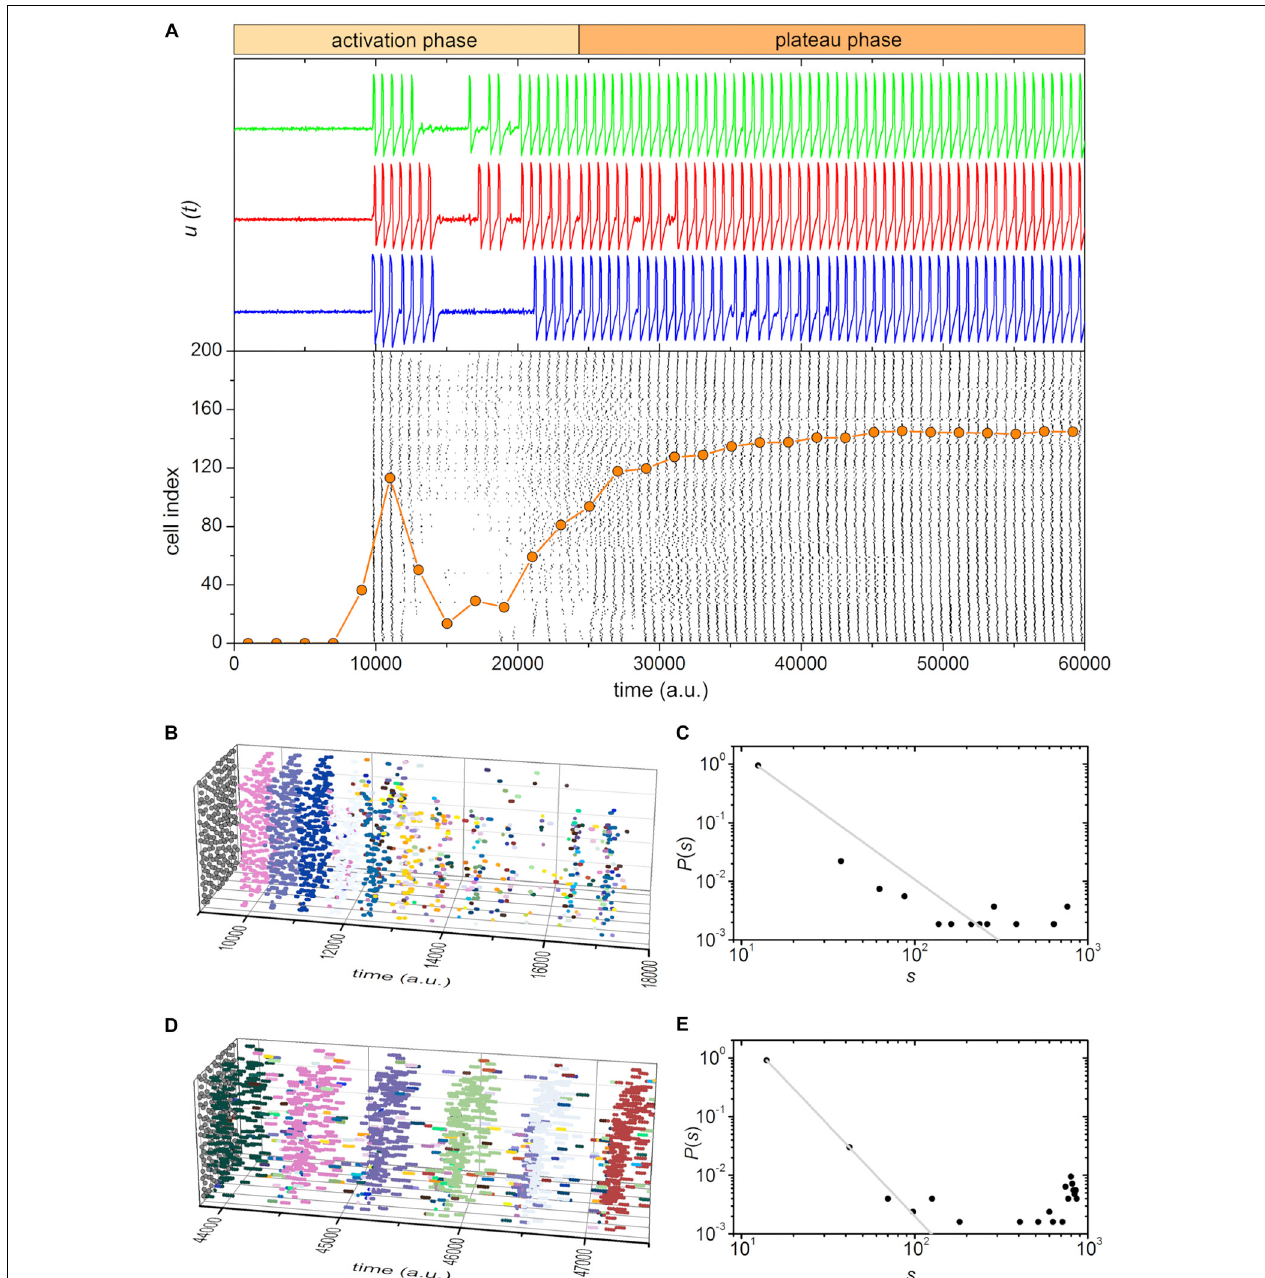
FIGURE 7 | Simulated beta cell responses after switching from a substimulatory to a suprastimulatory level of stimulation, i.e., from 6 to 12 mM glucose. (A) Three characteristic traces of simulated cellular dynamics and the raster plot of binarized cellular activity. The orange dotted line indicates the fraction of active cells within the given time-window that was slid throughout the simulation. (B,D) 3D raster plots showing the excitation waves for selected intervals for the activation (B) and plateau (D) phase. Colors denote individual waves. (C,E) The distributions of excitation wave sizes for the activation (C) and plateau (E) phase. The gray dashed line indicates the power-law